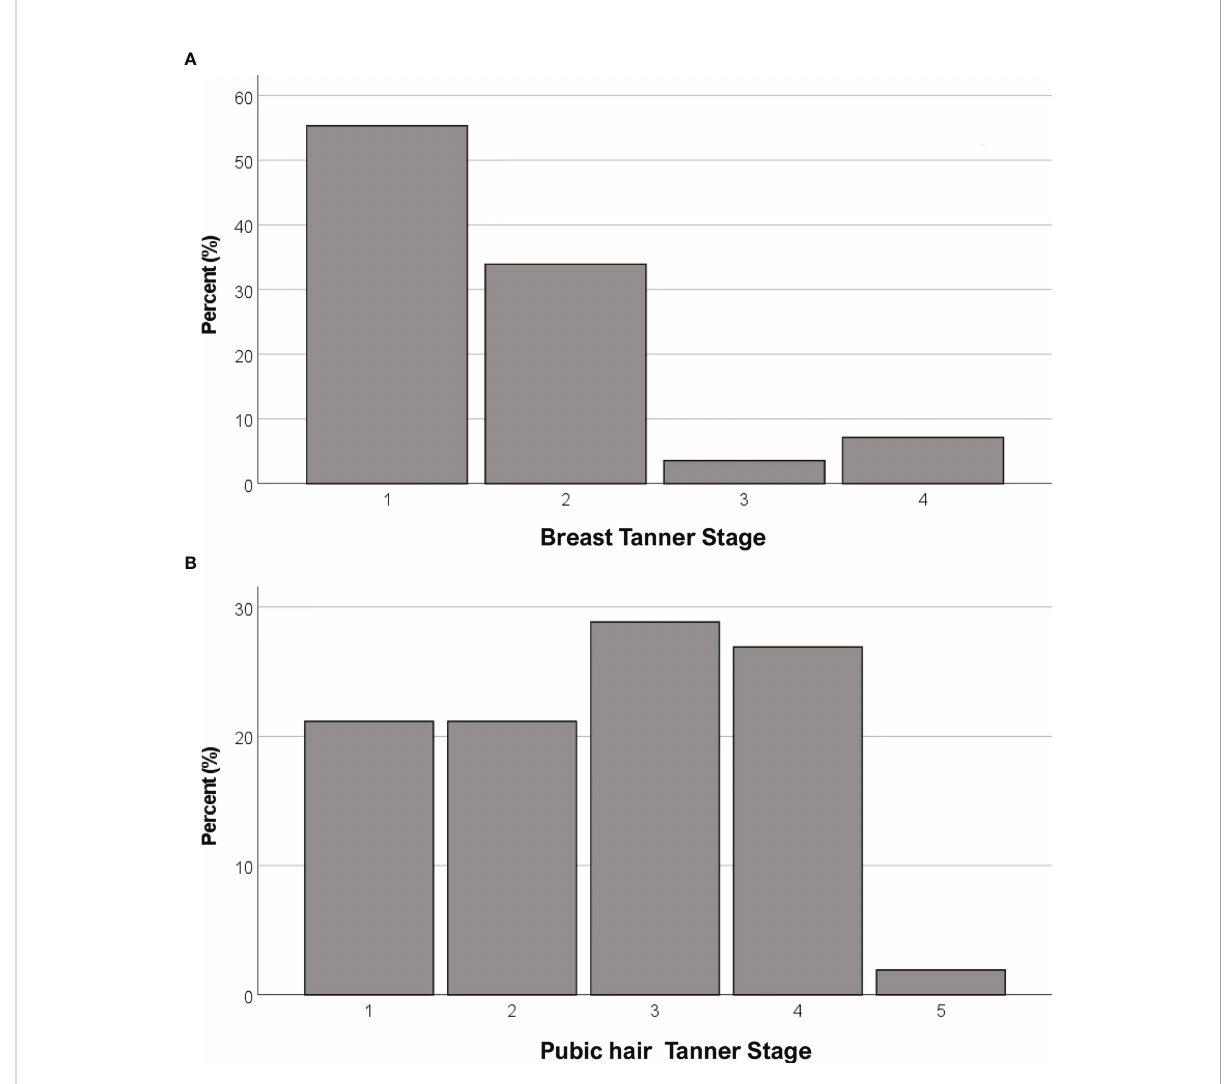
FIGURE 7 Distribution of female CHH patients for Breast Tanner Stages (A) and Pubic hair Tanner Stage (B)